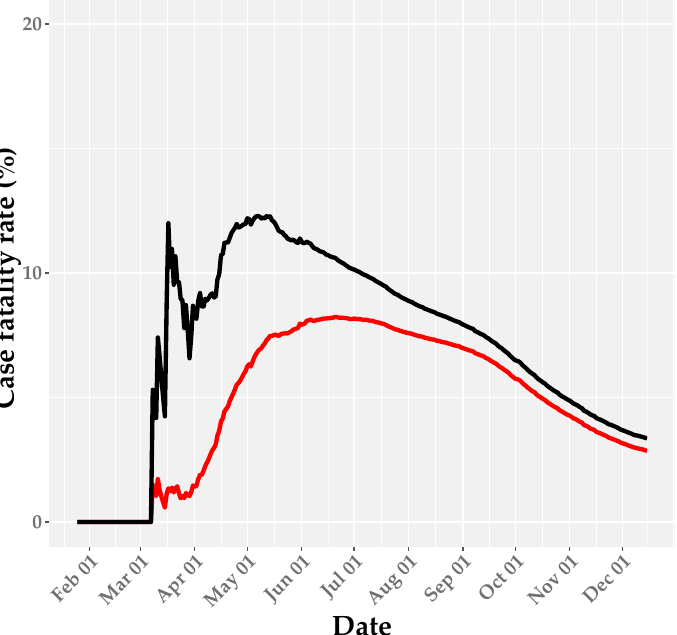
Figure 2. Crude case fatality rate (CFR; red line) and adjusted CFR estimates (black line) in Canada up to 15 December 2020. The shaded area around the black line illustrates the 95% credible interval (CrI) for the adjusted CFR.